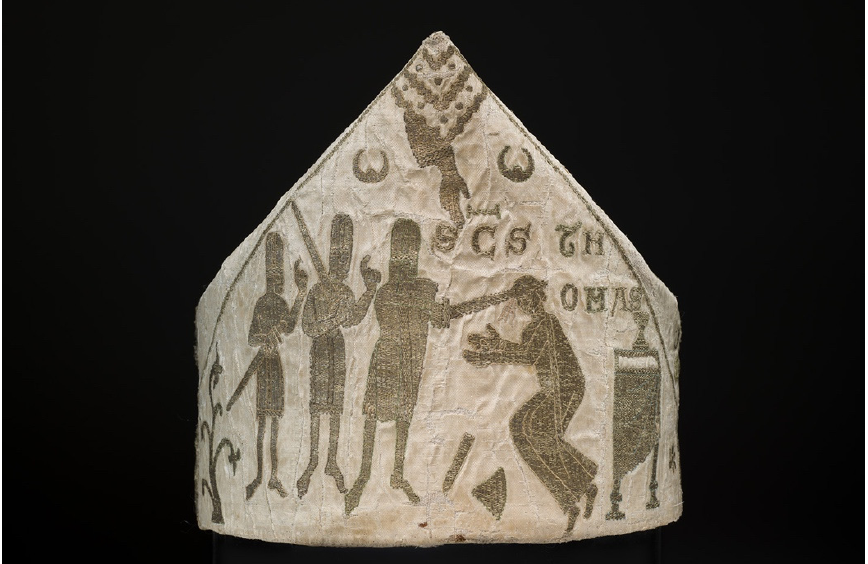
Figure 3. Seligenthal Mitre, front face with the martyrdom of Becket, early 13th century. Munich, Bayerisches Nationalmuseum, Germany. © Munich, Bayerisches Nationalmuseum.